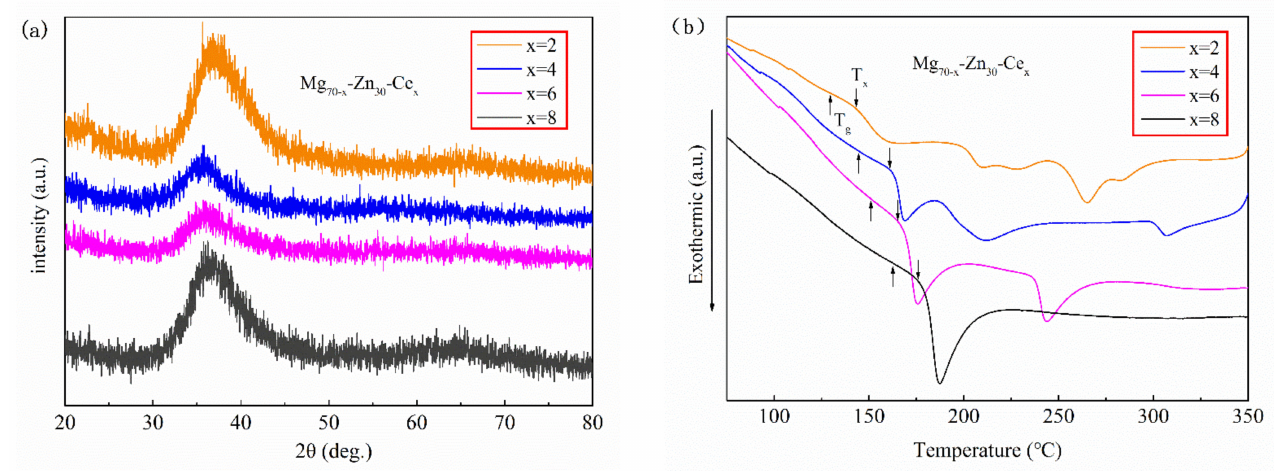
Figure 1. ( a ) XRD image of the magnesium-based amorphous alloy ribbon with Ce content, ( b ) DSC curves of the ribbons with different Ce element